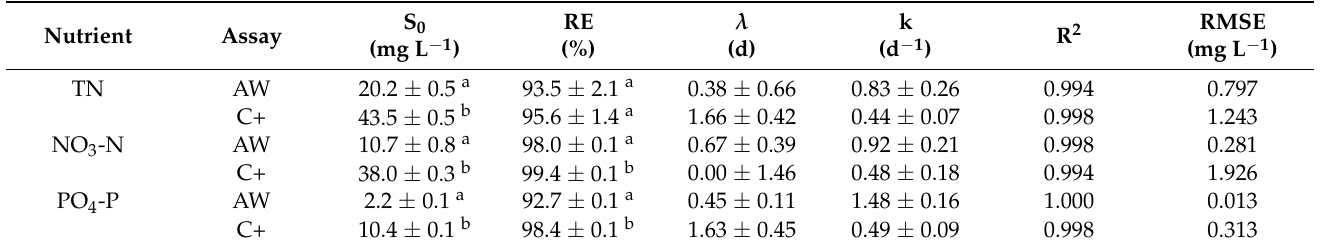
Table 3. Removal efficiencies, modified Gompertz model parameters and fitting performance indexes achieved for each assay.